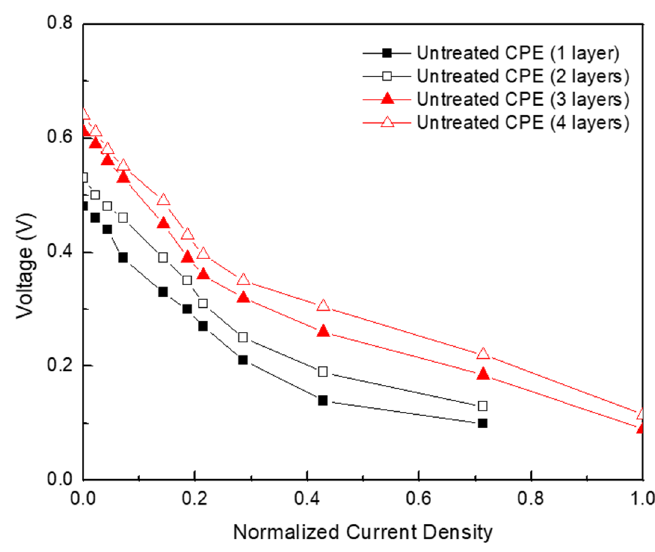
Figure 6. Effect of the thickness of the carbon porous electrode (CPE) on the cell performance. The thickness of the electrode was controlled by stacking sheets of carbon paper to make the multi-layered structure.